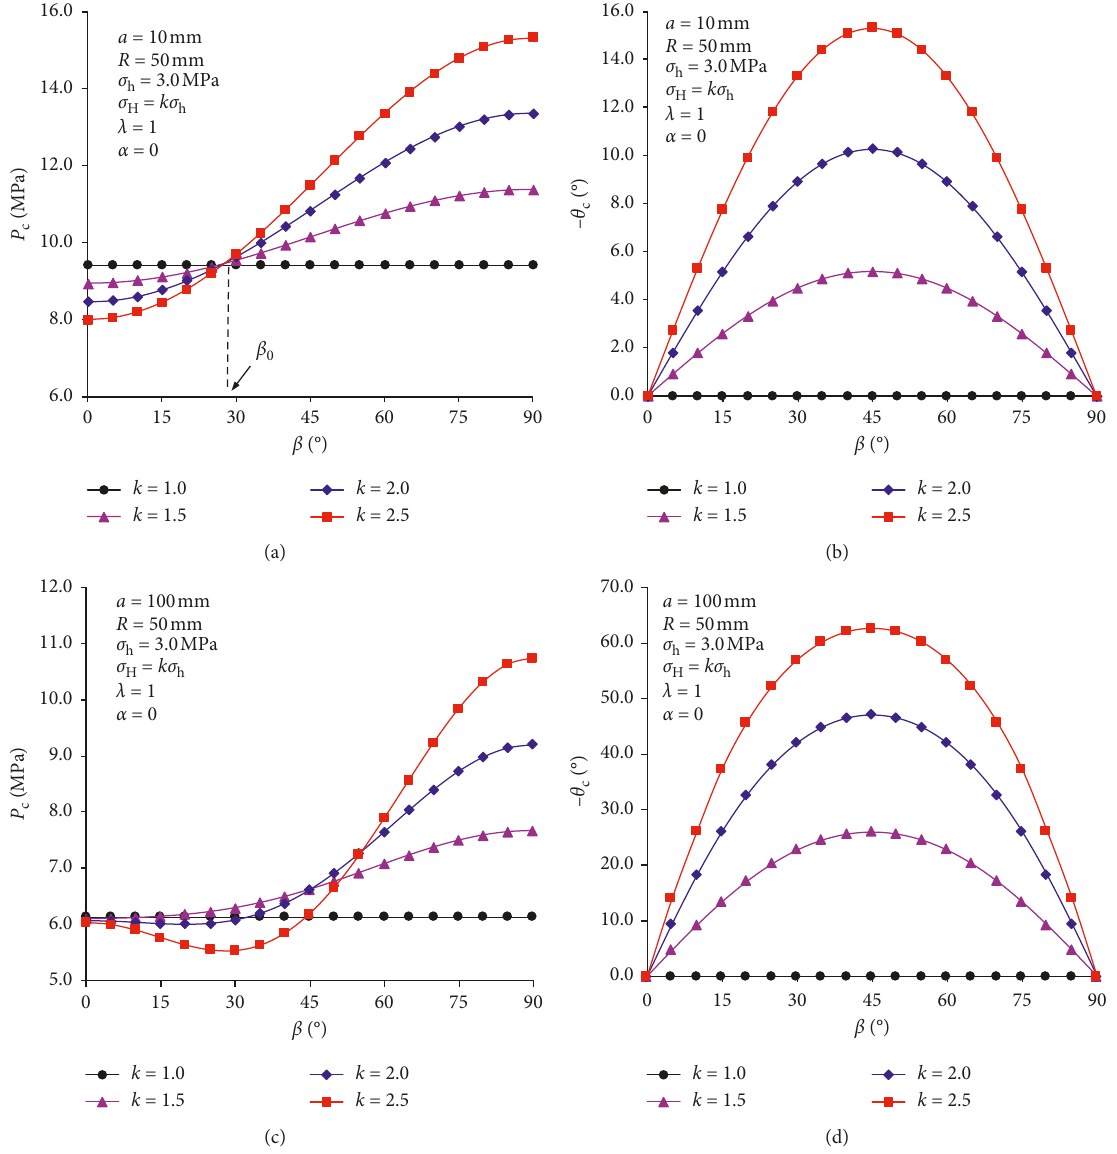
Figure 8: Effect of the stress anisotropy coefficient on the critical water pressure and critical initiation